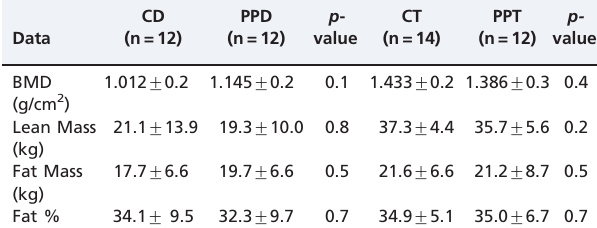
Table 3 - Body composition and total body bone mineral density in the control groups (CD and CT) and in patients with idiopathic central precocious puberty at diagnosis (PPD) and after treatment (PPT) with